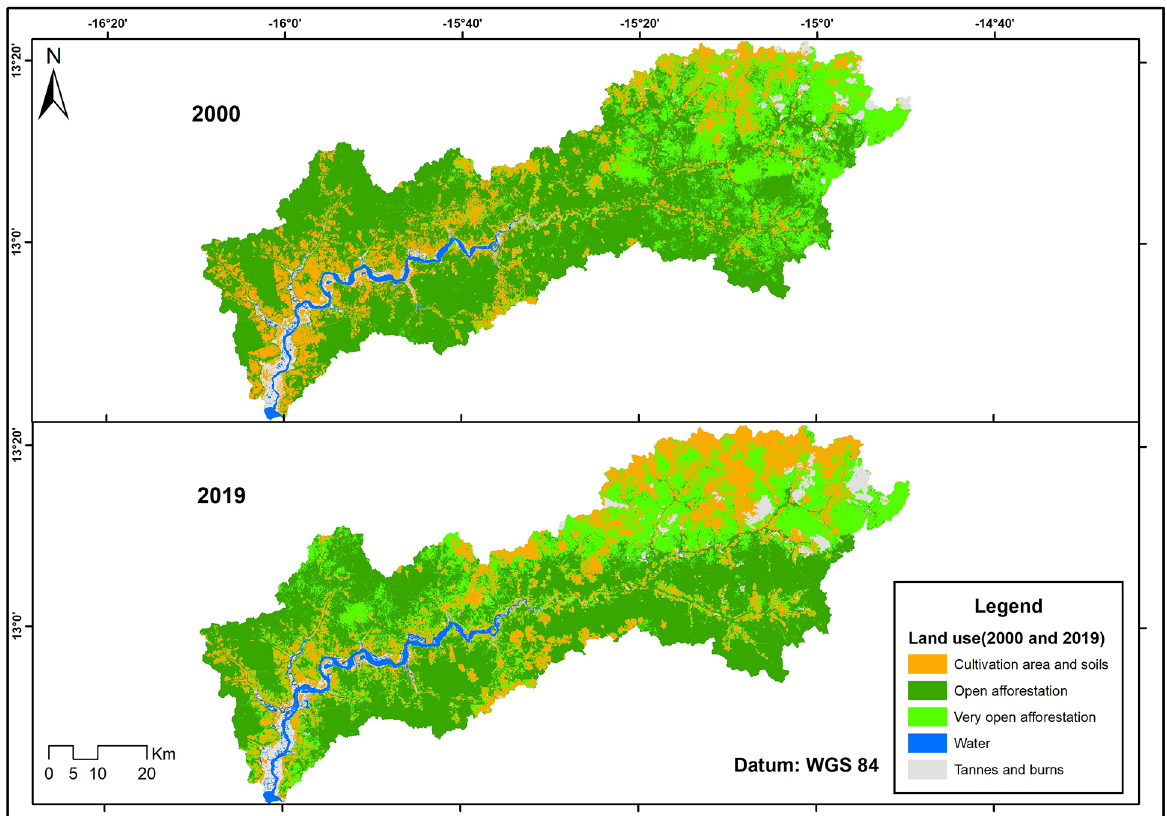
Fig. 5. Land use in the Soungrougrou basin in 2000 and